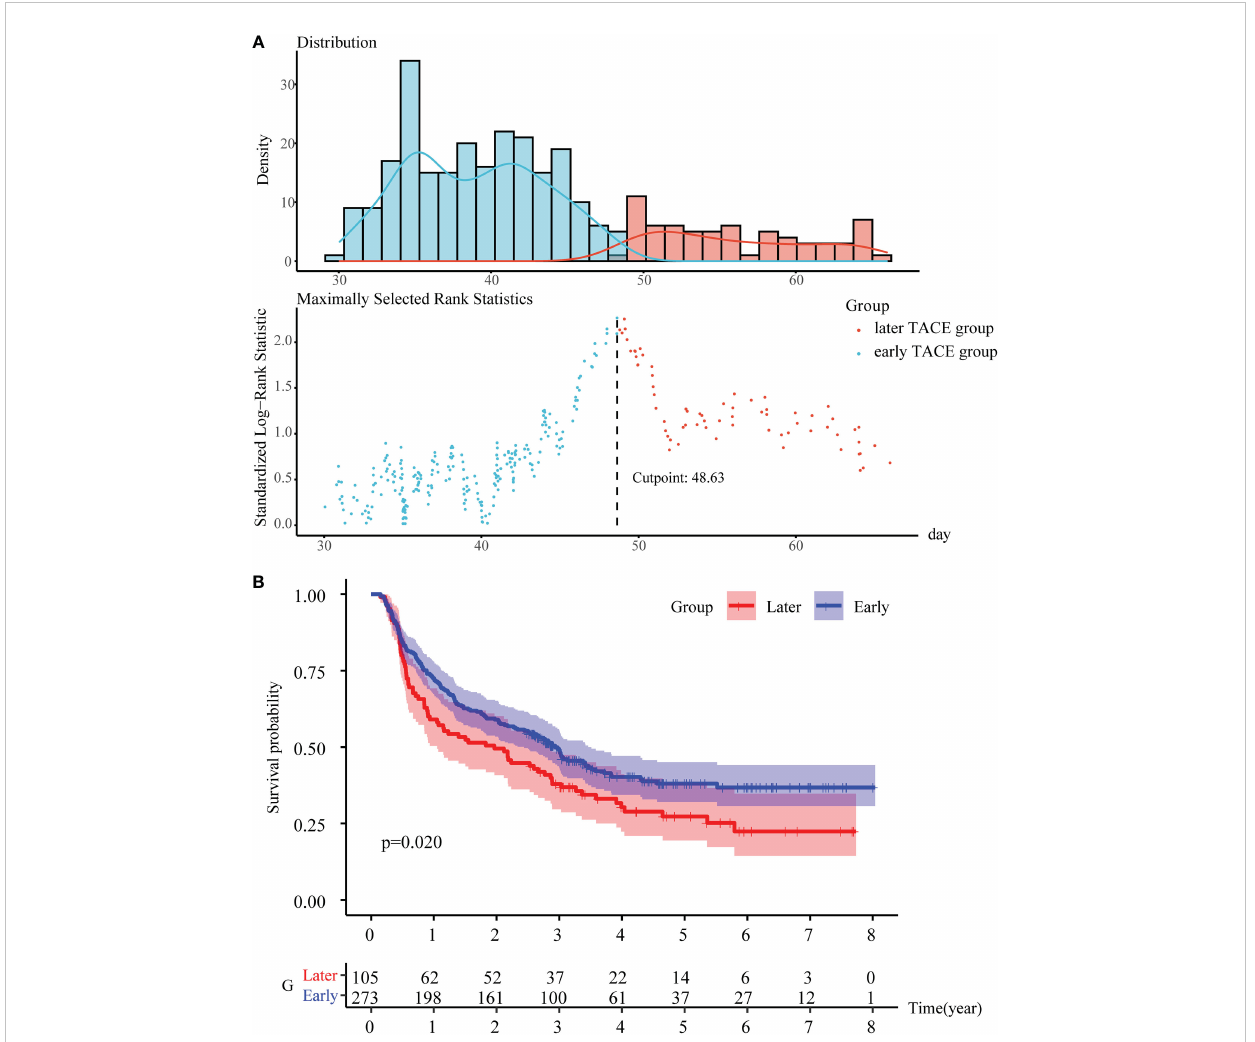
FIGURE 2 To determine the PA-TACE time cutoff values with signi fi cant prognostic differences. (A) Use the “ survminer ” package to get the optimal cutoff value for PA-TACE time. (B) K-M survival analysis of the early and later TACE groups for RFS. Abbreviations: PA-TACE, postoperative adjuvant TACE; RFS, disease-free